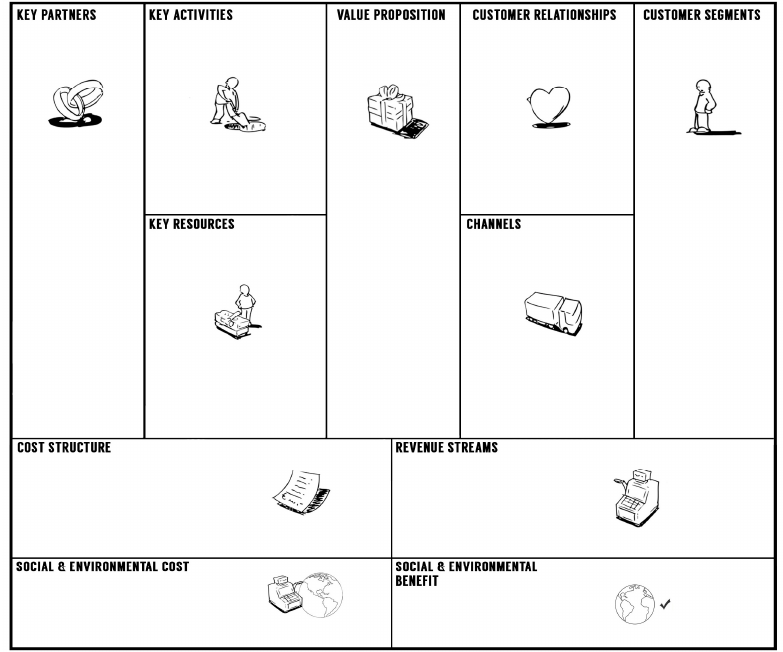
Figure 1. Non-Profit Business Model Canvas [88].